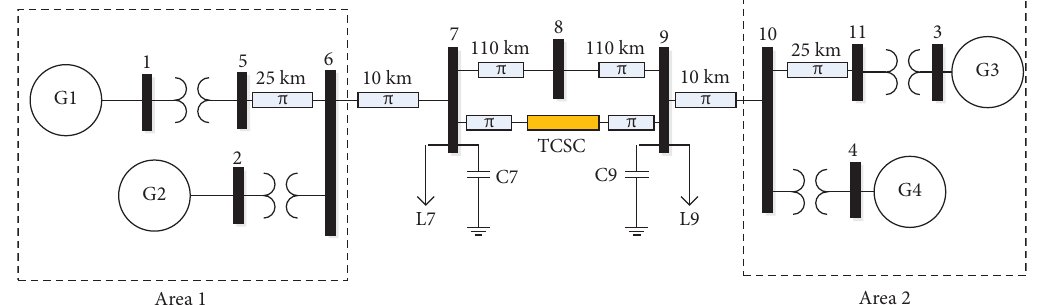
Figure 12: Te understudy power